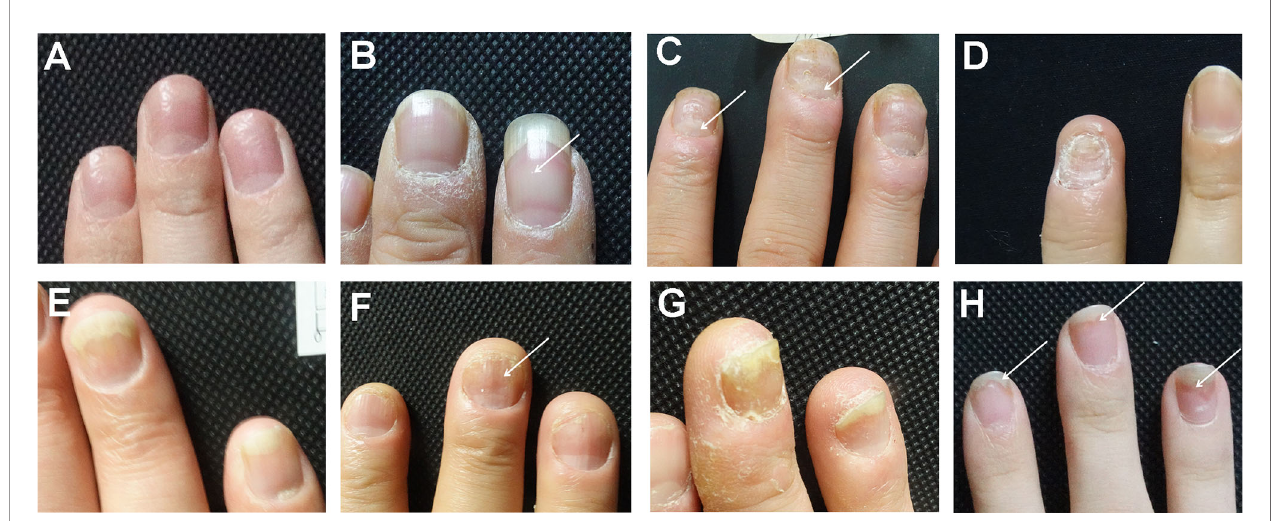
FIGURE 1 | The clinical manifestations of nail involvement of psoriasis. (A) Pitting. (B) Leukonychia. (C) Erythematous lunula. (D) Onychorrhexis. (E) Onycholysis. (F) Oil drop. (G) Subungual hyperkeratosis. (H) Splinter